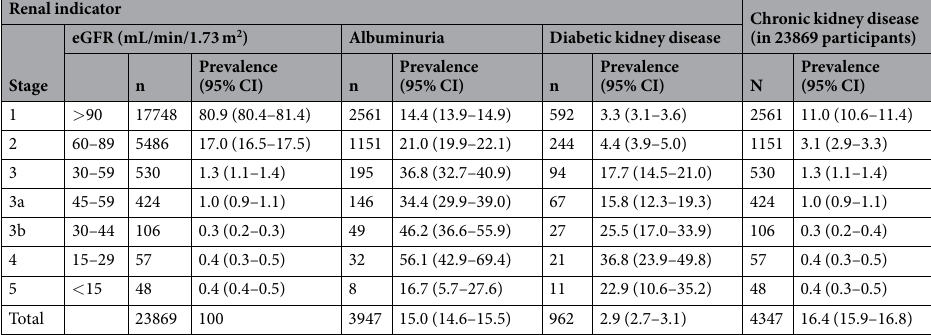
Table 2. Adjusted prevalence of indicators of renal function and chronic kidney disease, by disease stage. Note: Albuminuria was defined as urinary albumin to creatinine ratio > 30 mg/g creatinine. CKD was defined as an eGFR less than 60 mL/min/1.73 m 2 or presence of albuminuria. All prevalences were adjusted for synthesized weights. Abbreviations: eGFR, estimated glomerular filtration rate.